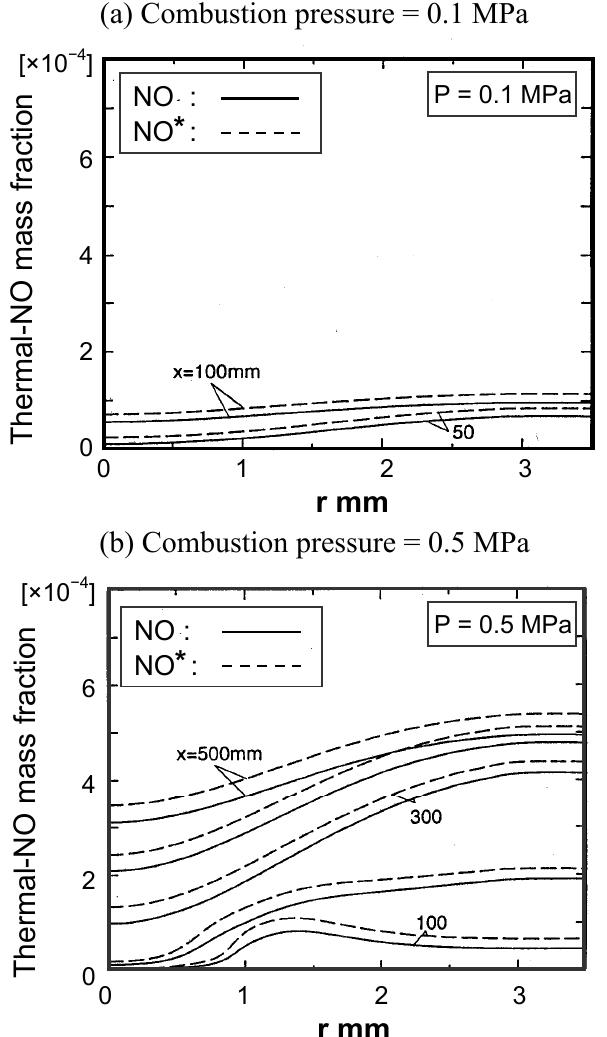
Figure 61. Radial profiles of thermal-NO production at each section in flames. Solid lines: Thermal-NO originated from N . Broken lines: Thermal-NO in case of fuel containing 2 no